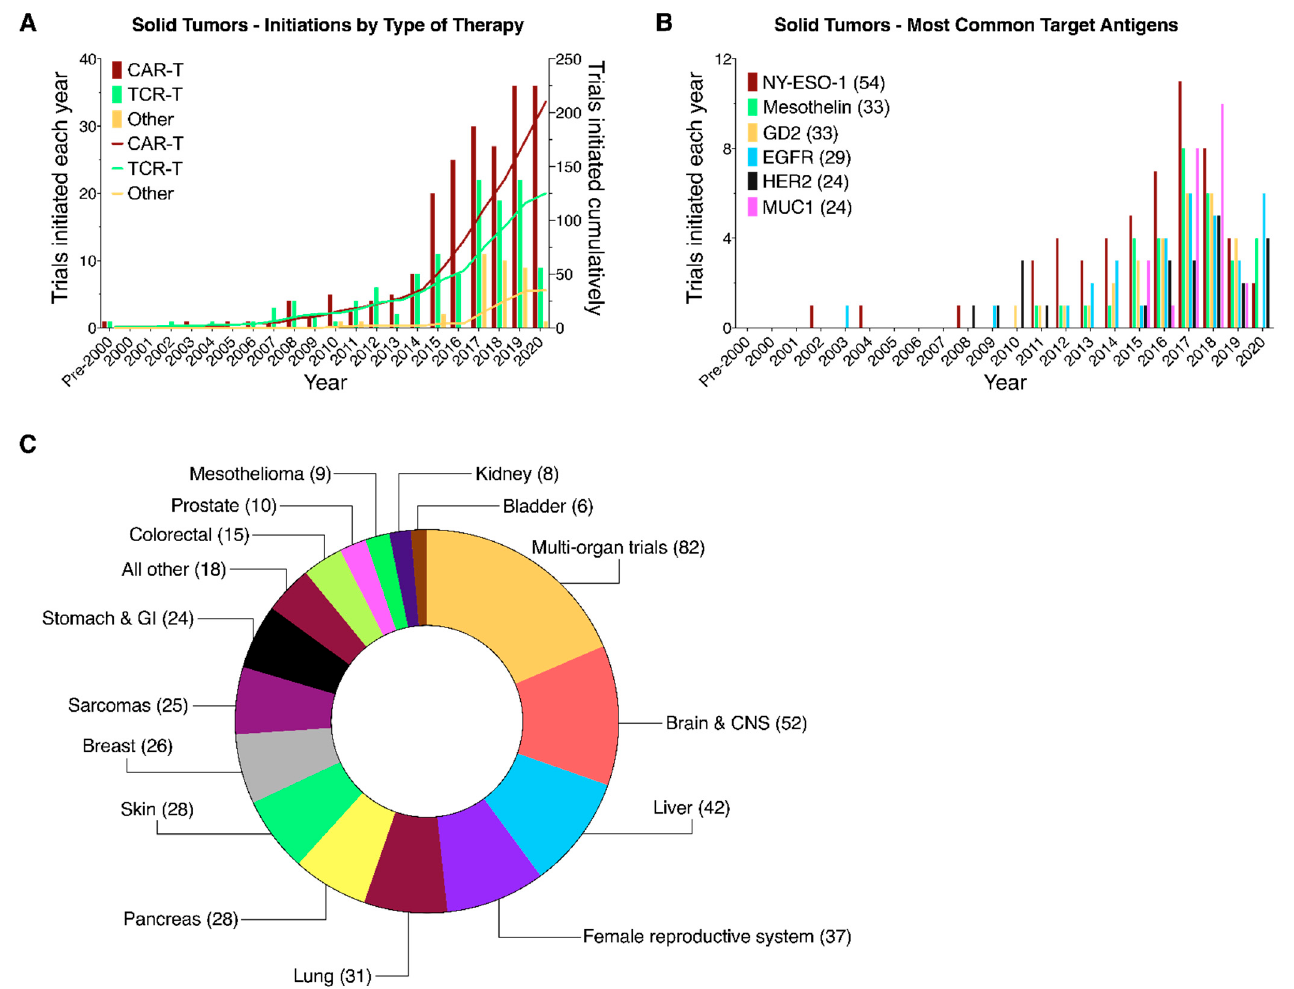
Figure 6. CAR-T/TCR-T clinical trials targeting solid tumors. Yearly (bars) and cumulative (lines) numbers of CAR-T/TCR- T trials registered on clinicaltrials.gov and initiated on or before 31 December 2020 targeting hematologic cancers. Trials were segmented by ( A ) type of therapy, ( B ) commonly targeted antigens, and ( C ) the tissue of origin.